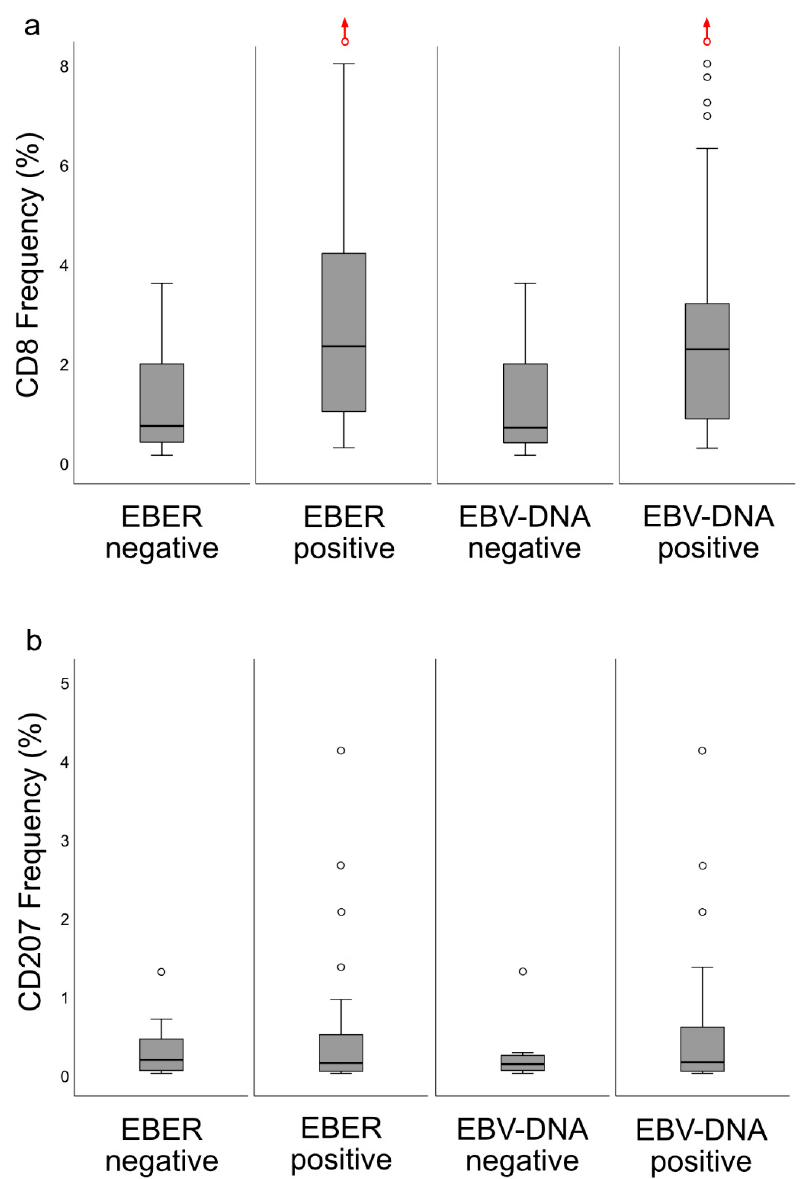
Figure 7. Frequency (%) for CD8 and CD207 (whole biopsies) grouped according to presence or not of intralesional EBER and EBV DNA, respectively, and presented as boxplots (median and IQR with whiskers denoting 1.5 IQR and outliers as circles): ( a ) CD8 ratios were higher for EBER-positive lesions ( p = 0.0065) and for EBV DNA-positive lesions ( p = 0.028); ( b ) in contrast, there were no such di ff erences for CD207 ratios. An extreme outlier (frequency: 24%), deemed an accurate finding, is indicated with a red circle and an upwards-pointing red arrows. Abbreviations: EBER = Epstein–Barr virus-encoded small RNA, EBV = Epstein–Barr virus, and IQR = interquartile